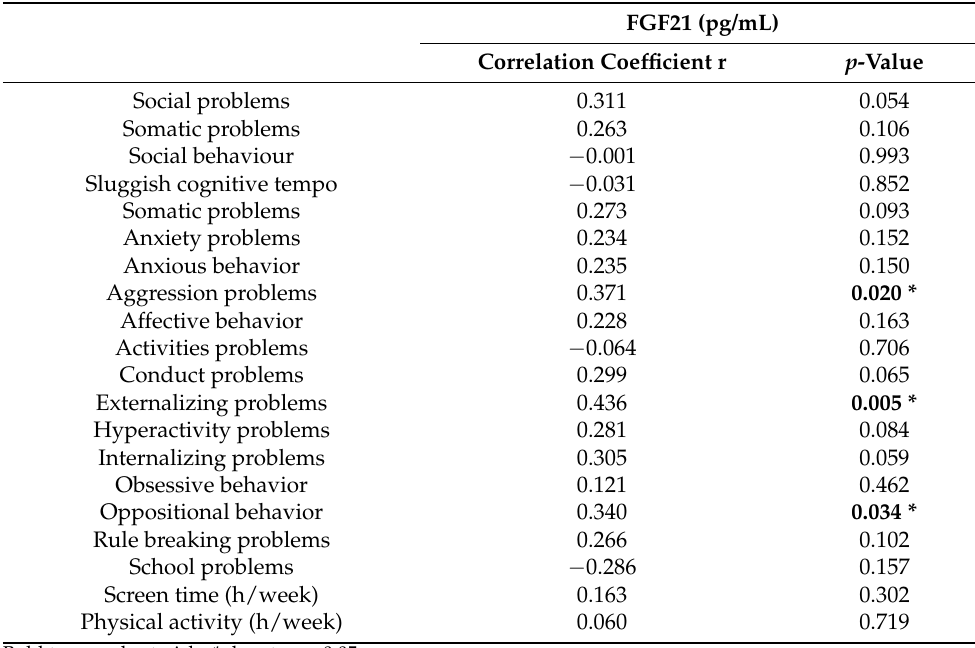
Table 2. Spearman correlation results between serum FGF21 and behavioral factors in the OB